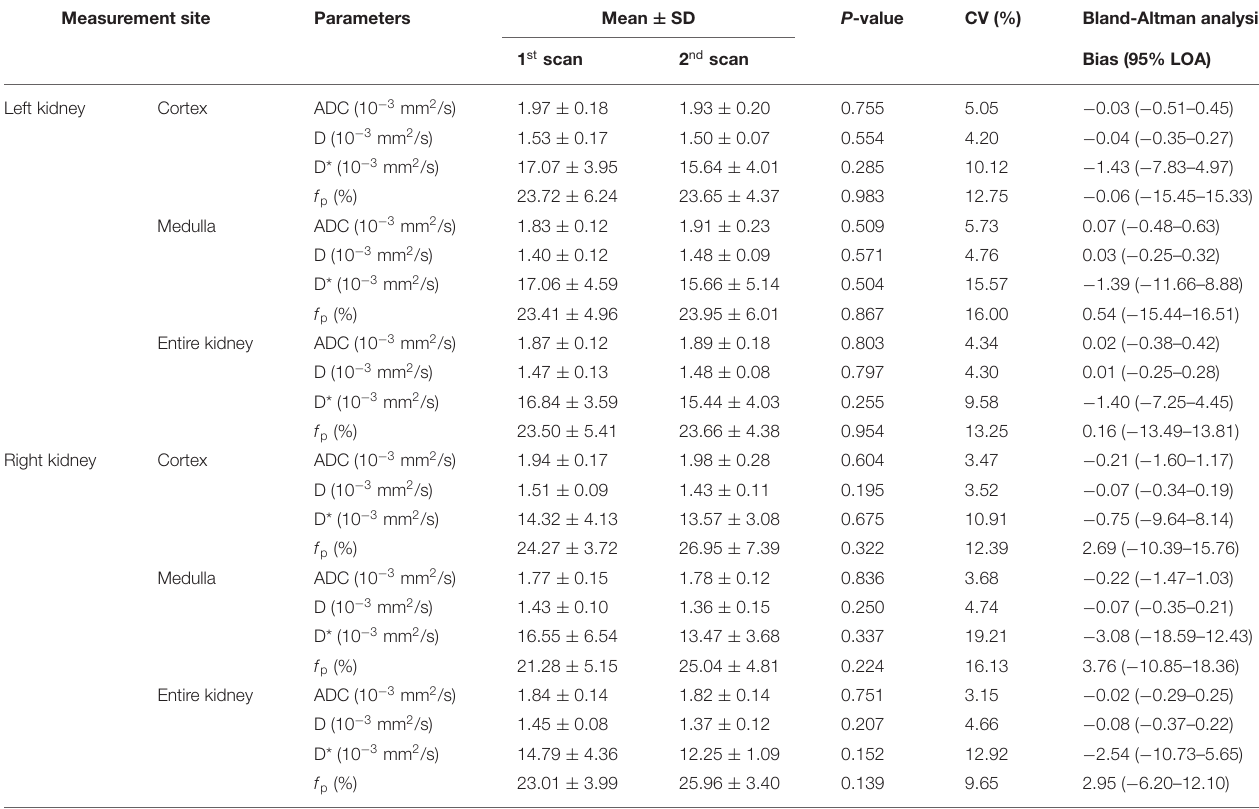
TABLE 6 | Difference, coefficient of variance, and Band-Altman agreement of the ADC, D, D * , and f p in bilateral renal cortex and medulla between the first and second scans in healthy dogs. Measurement